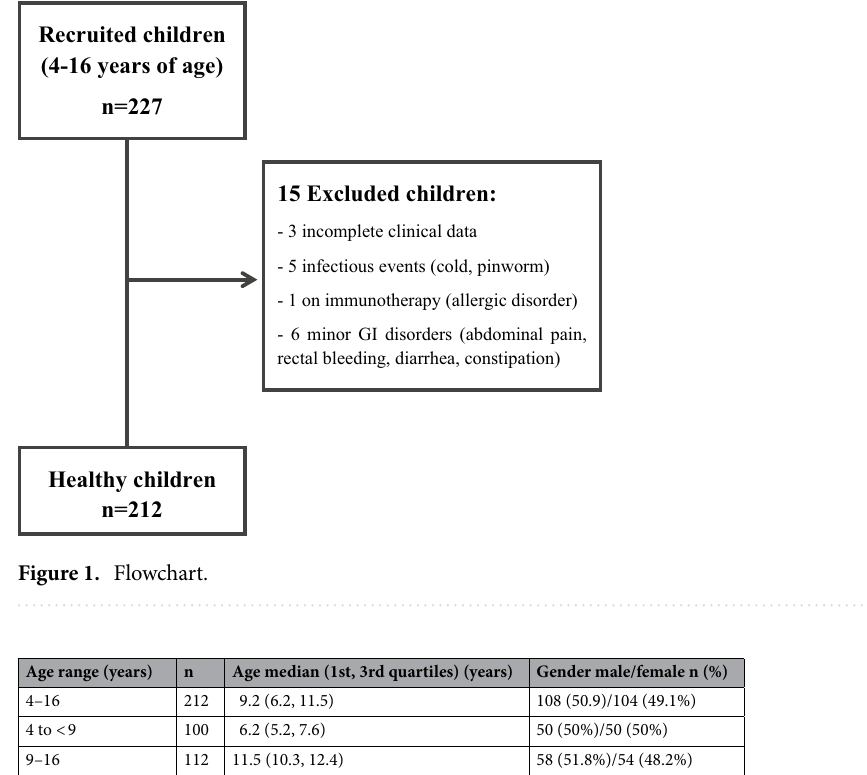
Table 1. Characteristics of the study population.